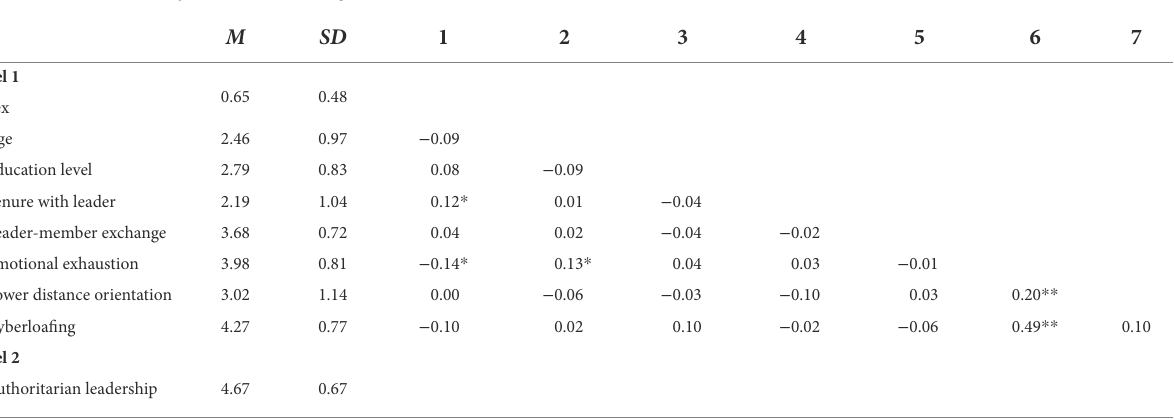
TABLE 2 Results of descriptive statistical